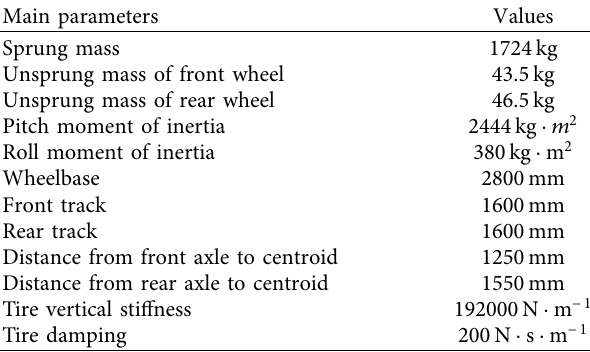
Figure 5: Road and tire model. Table 1: Main parameters of